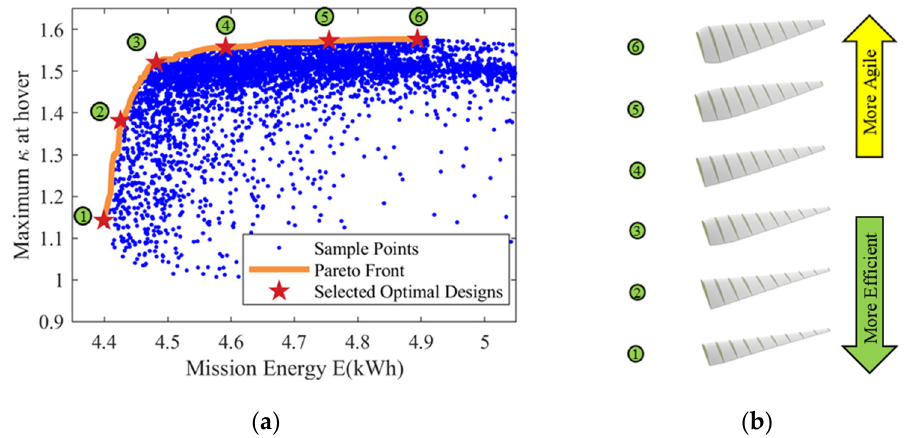
Figure 15. Pareto front and optimal VPPs. ( a ) Sample points and Pareto front; ( b ) geometries of the propeller.